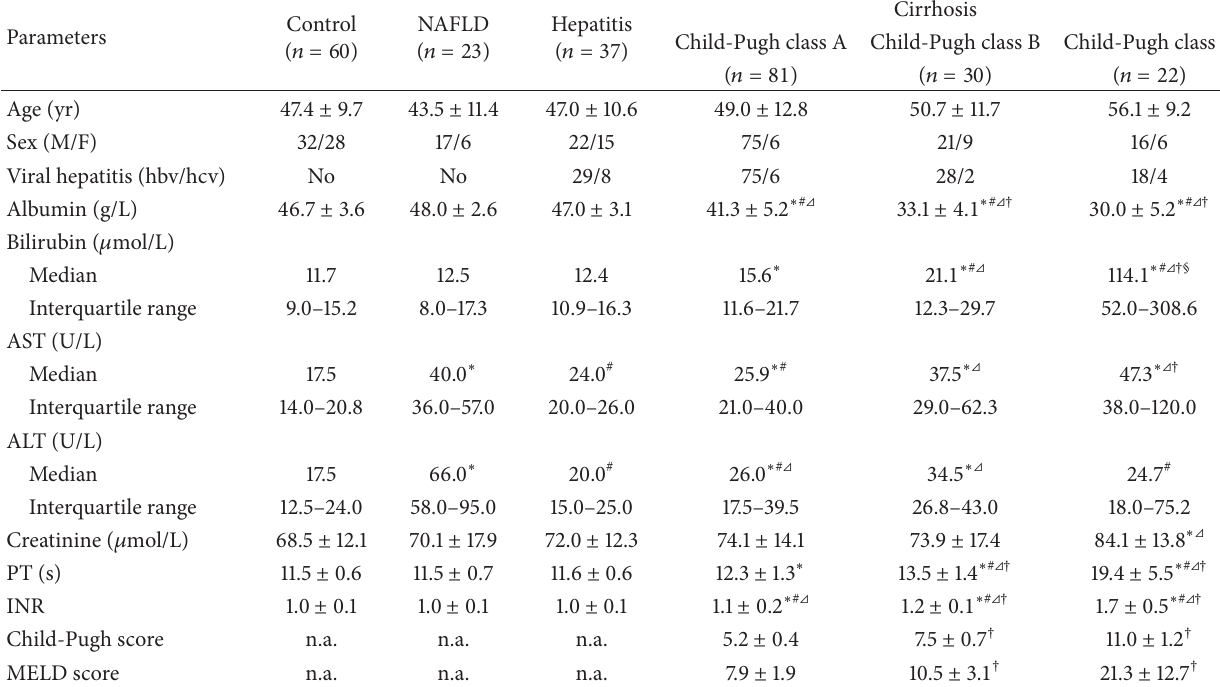
Table 2: Baseline characteristics of the participants in different subjects groups.